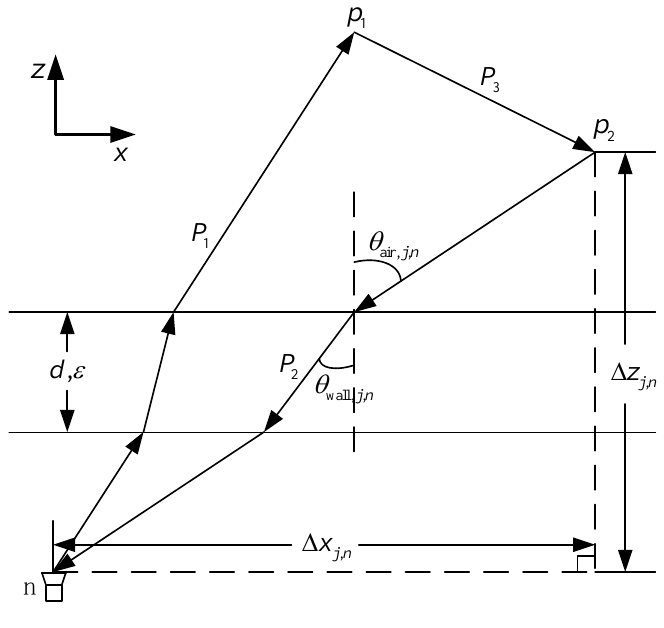
Figure 1. Propagation model of interaction